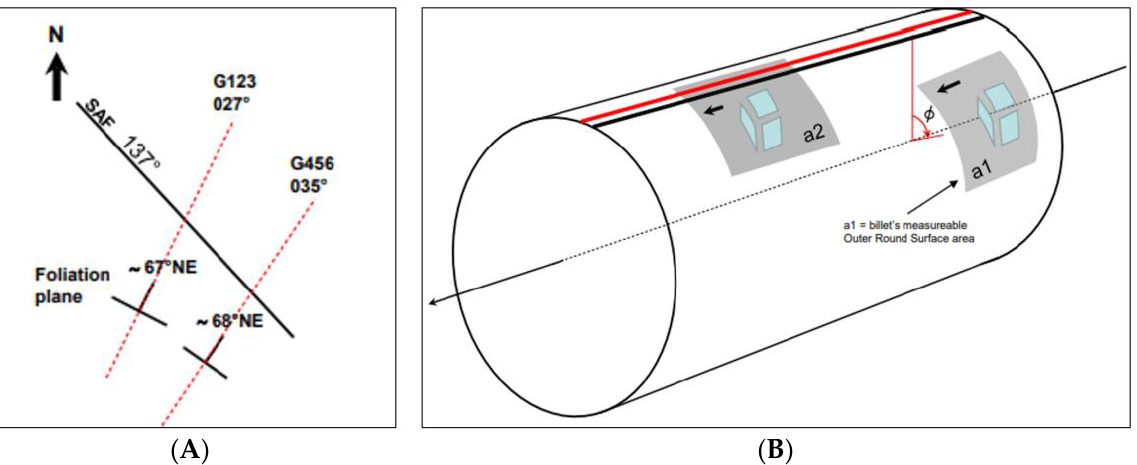
Figure 9. ( A ) Map view of SAF bearing 137° SE through California, core sections G123 and G456 cutting across the SAF with compass bearings of 027° NE (plunge of 67°) and 035° NE (plunge of 68°), respectively. ( B ) Schematic depiction of borehole depicting billet clockwise angle with respect to red and black core orientation lines.